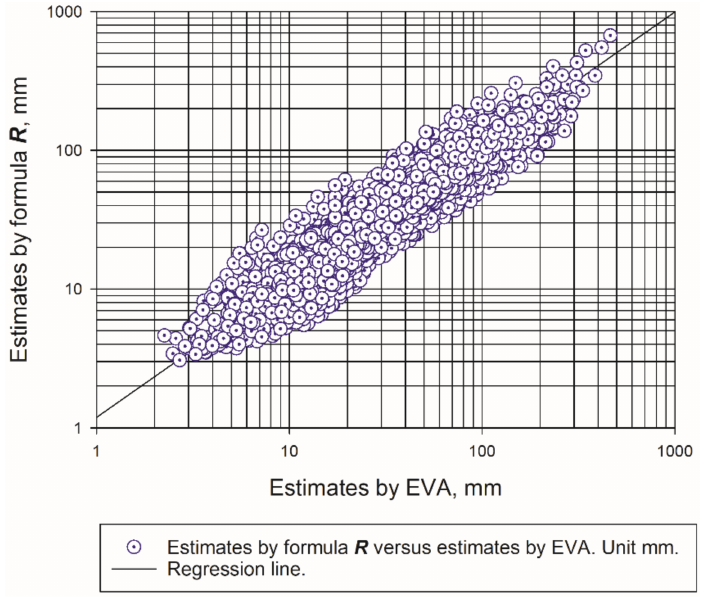
Figure 5. Dataset R2 for the application of the relationship R . This dataset consists of 78 locations with 4306 pairs of estimated and corresponding EVA intensity